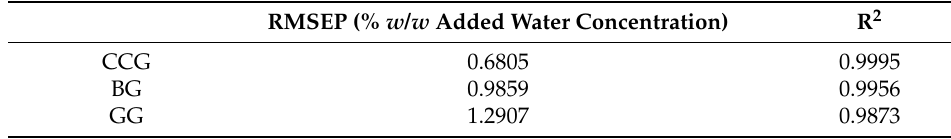
Table 3. Summary of RMSEP obtained from PLSR applied on Test SET (SET_03).